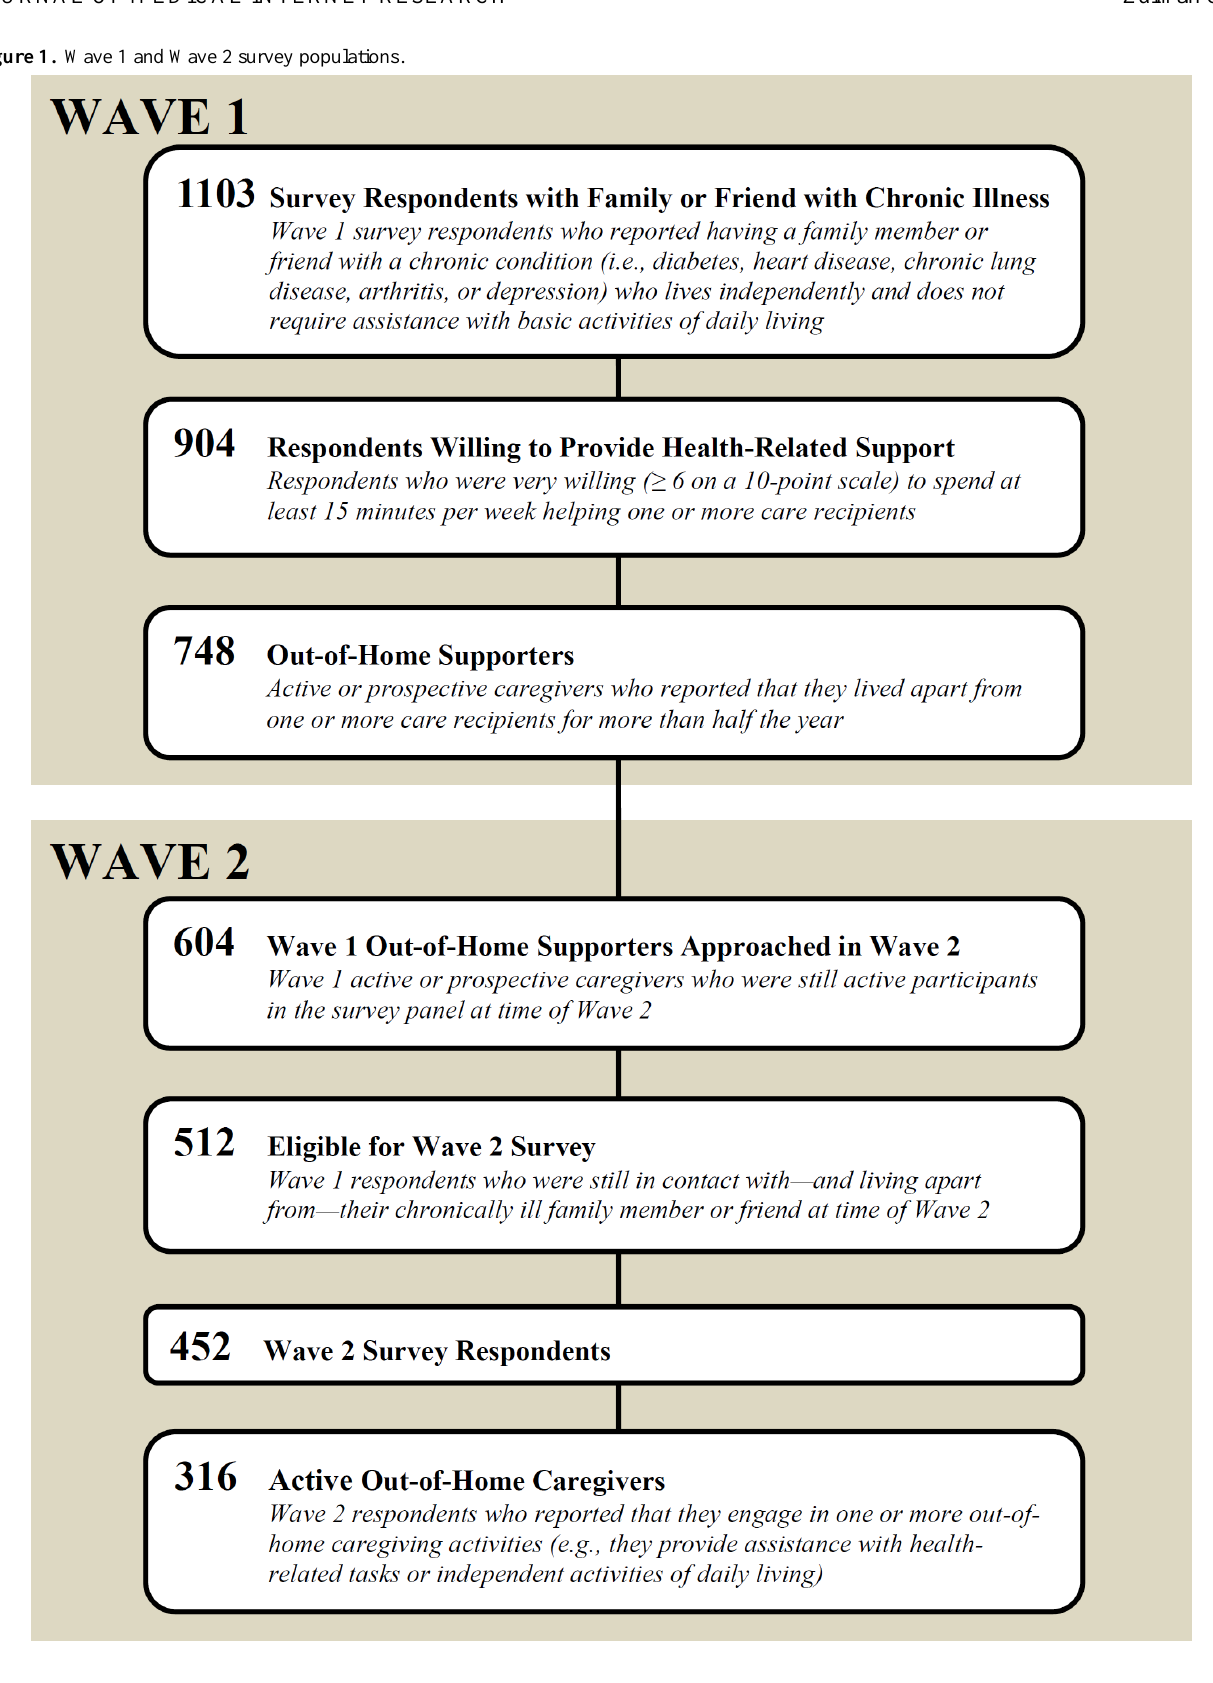
Figure 1. Wave 1 and Wave 2 survey